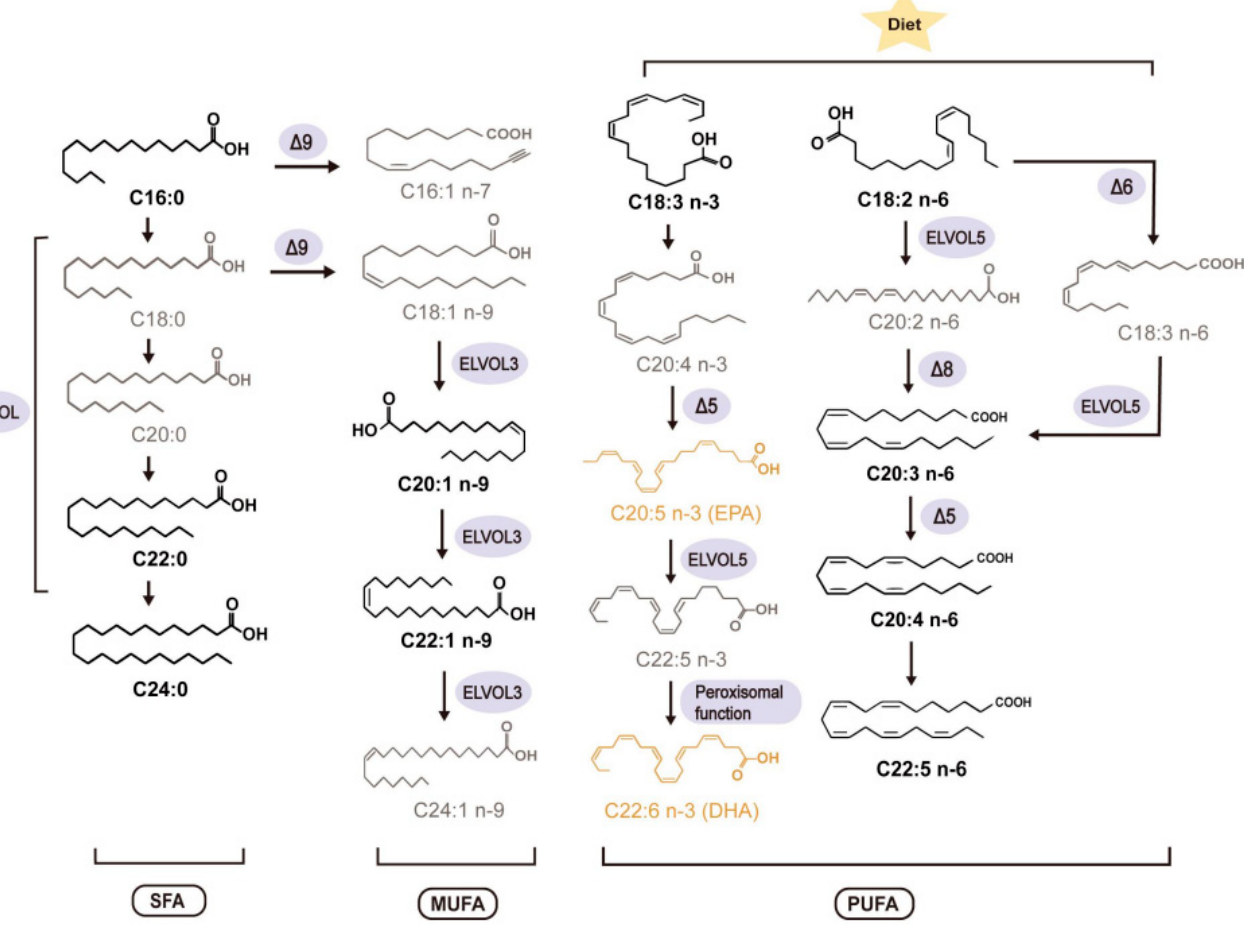
Figure 1. Fatty acid elongation and desaturation processes: SFA, saturated fatty acids; MUFA, monounsaturated fatty acid; PUFA, polyunsaturated fatty acids; ∆ 6D, delta-6-desaturase; ∆ 5D, delta-5-desaturase; ∆ 9D, delta-9-desaturase. Eicosapentaenoic acid (C20:5 n-3, EPA) and docosahexaenoic acid (C22:6 n-3; DHA) (omega-3 quotient) are highlighted in orange font. Bold font FAs showed negative A–V differences (bioaccumulation) in RBCs after passage through upper limbs before dialysis treatment.